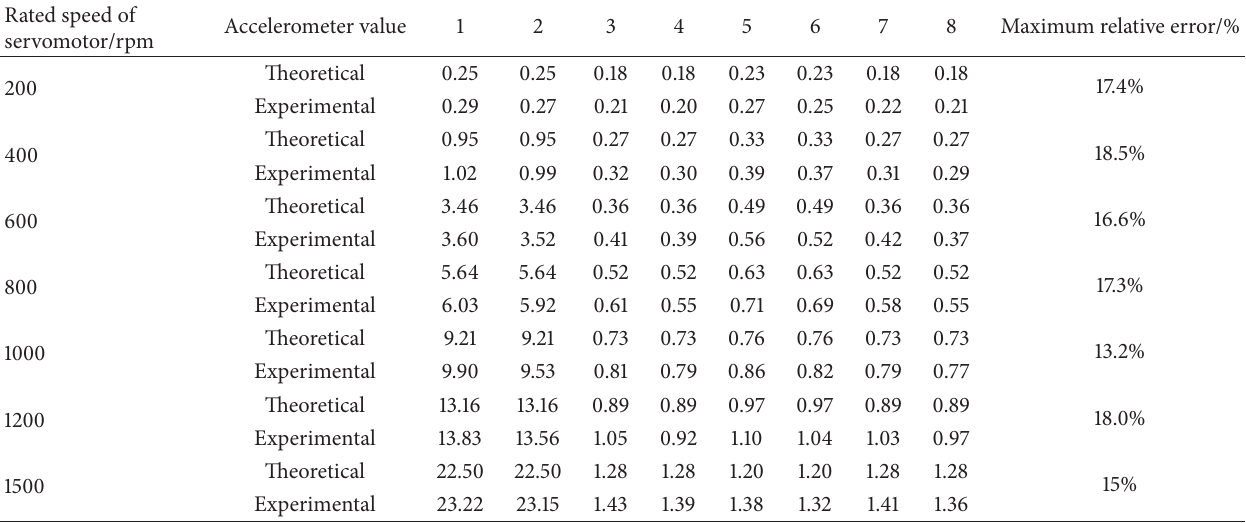
Table 4: Experimental and theoretical values of acceleration of main components for different speeds of the servomotor (m/s 2 ). Rated speed of Accelerometer servomotor/rpm